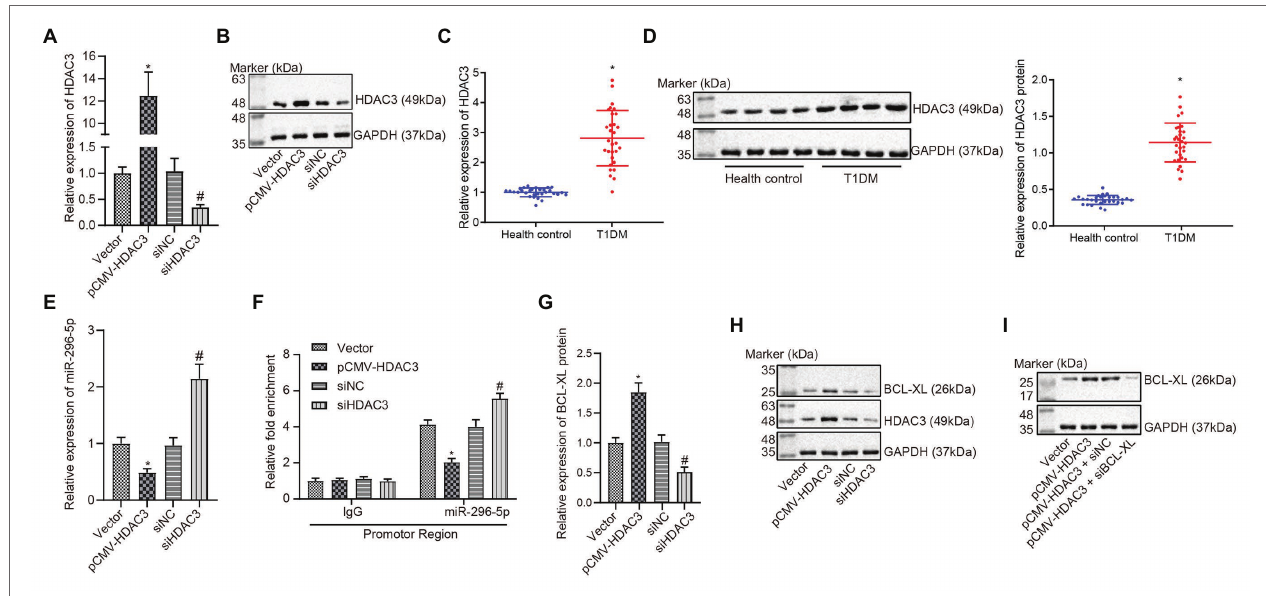
FIGURE 4 | HDAC3 restricts the expression of miR-296-5p by binding to with its promoter region. (A) The expression of Hdac3 determined by RT-qPCR. (B) The expression of HDAC3 determined by Western blot assay. (C) The expression of Hdac3 in PBMCs of T1DM patients by RT-qPCR. (D) The expression of HDAC3 in PBMCs of T1DM patients by Western blot assay. (E) The expression of miR-296-5p determined by RT-qPCR when HDAC3 was upregulated and downregulated, respectively. (F) Inhibition of miR-296-5p promoter activity by Hdac3 evaluated using ChIP-qPCR assay. (G) The expression of Bcl-xl determined by RT-qPCR when Hdac3 was upregulated or downregulated, respectively. (H) The expression of BCL-XL determined by Western blot assay when HDAC3 was upregulated or downregulated, respectively. (I) Rescue experiments showed that HDAC3 upregulated the expression of BCL-XL by targeting miR-296-5p . * p < 0.05 compared with cells transfected with vector, # p < 0.05 compared with cells transfected with si-NC. The results were measurement data and expressed as mean ± standard deviation. Data comparison between two groups was performed using unpaired sample t -test, and data comparisons among multiple groups were performed using one-way analysis of variance. The cell experiment was repeated three times